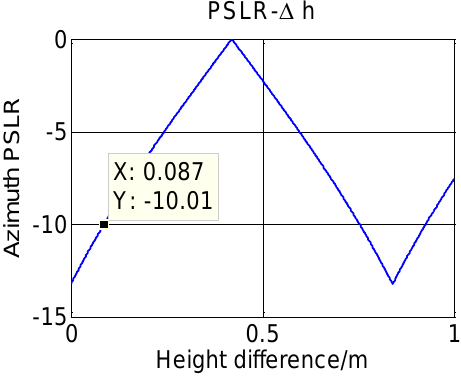
Figure 12. Relationship between PSLR and height difference.